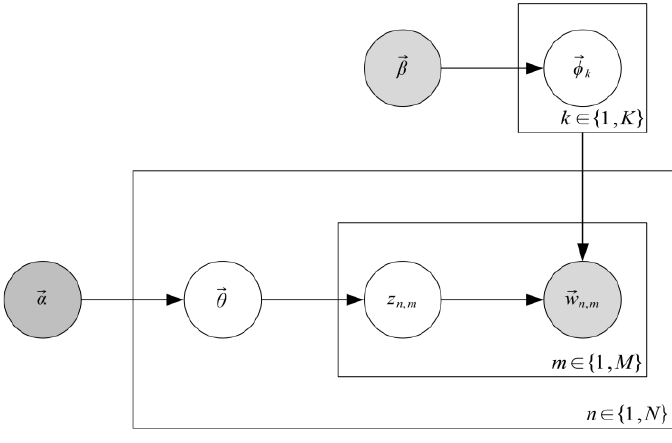
Figure 2. The LDA topic model.